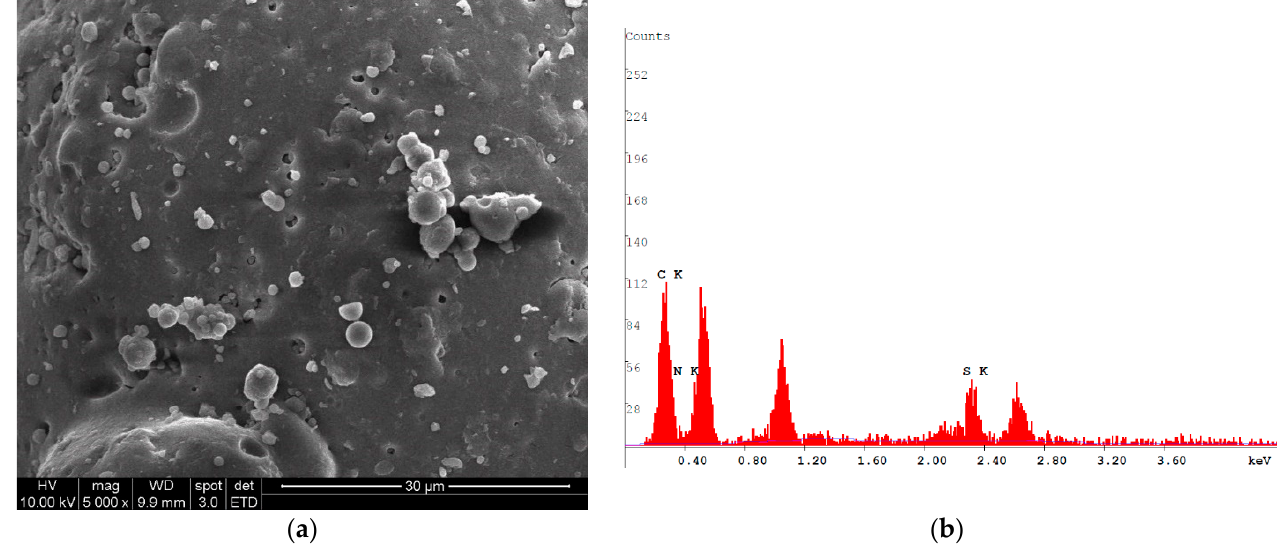
Figure 4. ( a ) SEM images (5000×) and ( b ) EDX spectra of purified ChS from jumbo squid cartilage.